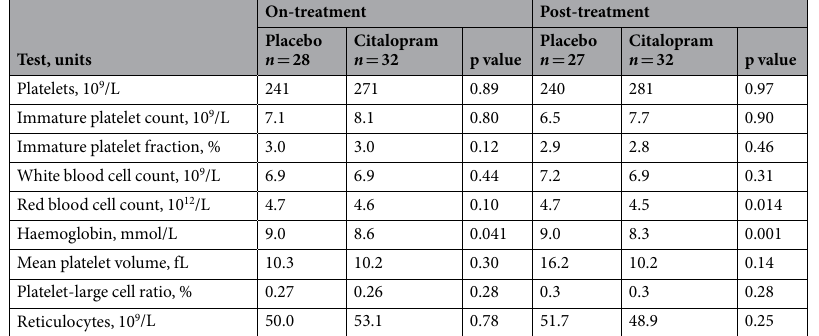
Table 1. Haematology parameters measured during treatment with both project medication and clopidogrel (On-treatment) and during treatment with clopidogrel monotherapy ( = Post-treatment). Calculations are based on mean values. fL: femtolitre (10 − 15